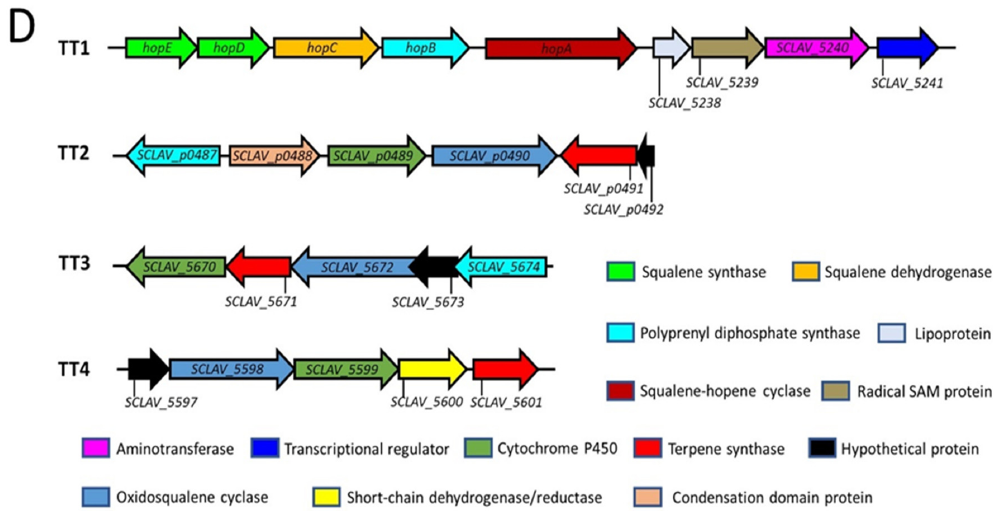
Figure 2. Triterpenoid molecular networks and related biosynthetic gene clusters (BGCs) corresponding to metabolites detected only in S. clavuligerus strains overexpressing different rpsL variants (K88E, L90K, and R94G). ( A ) Negative-mode molecular network comprising unknown and predicted triterpenoids from the current study. ( B ) Predicted structures of saponin triterpenoids annotated with network annotation propagation (NAP). ( C ) Structural prediction of another triterpenoid molecular network detected using positive-mode ionization. ( A , B and C ) Each node depicts a mass spectrum (labeled with m/z of the respective precursor mass) and edges represent the relationship between different nodes. ( B and C ) Top-ranked NAP-consensus structural predictions (red boundary) and those annotated by spectral library matching (green boundary) present in S. clavuligerus cultures overexpressing different rpsL variants (K88E, L90K , and R94G) (yellow fill) are shown. ( D ) BGCs proposed to be associated with the production of such metabolites in S. clavuligerus . TT1 is responsible for the production of hopanoids, whereas the products of the other three BGCs are not known.